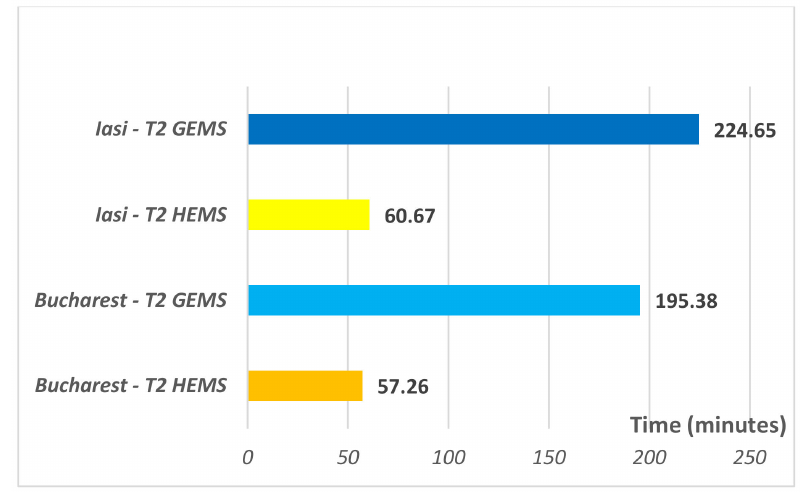
Figure 2. Effective air and ground transfer time (T2) to PCI